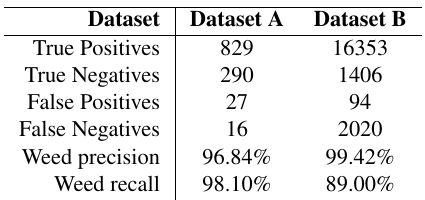
Table 4. Quality comparison of the classifier for the weed class trained in A.